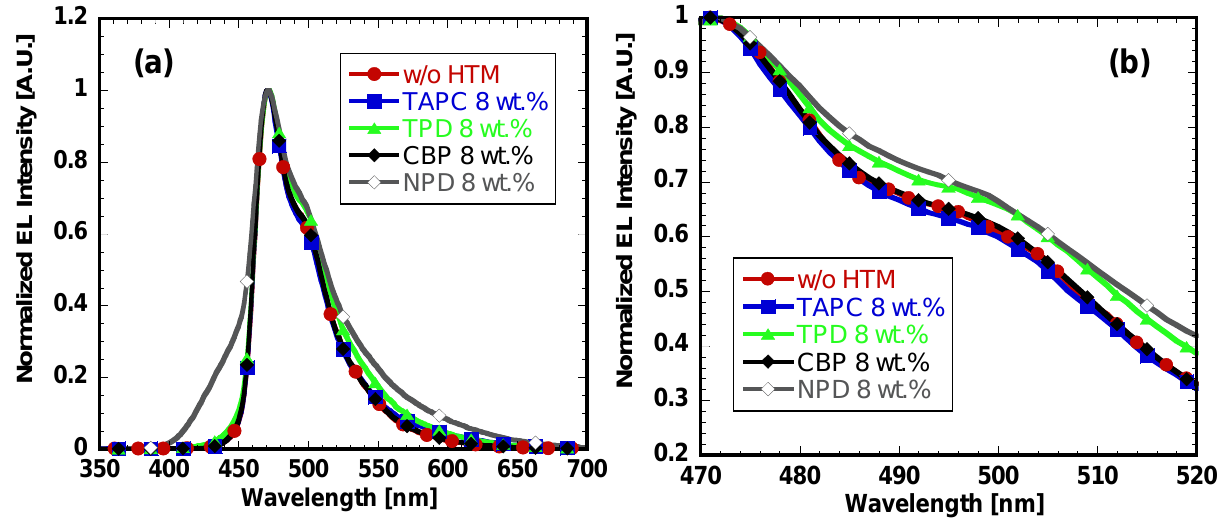
Figure 5. ( a ) EL spectra of the PHOLEDs; ( b ) EL spectra at 470 to 520 nm.